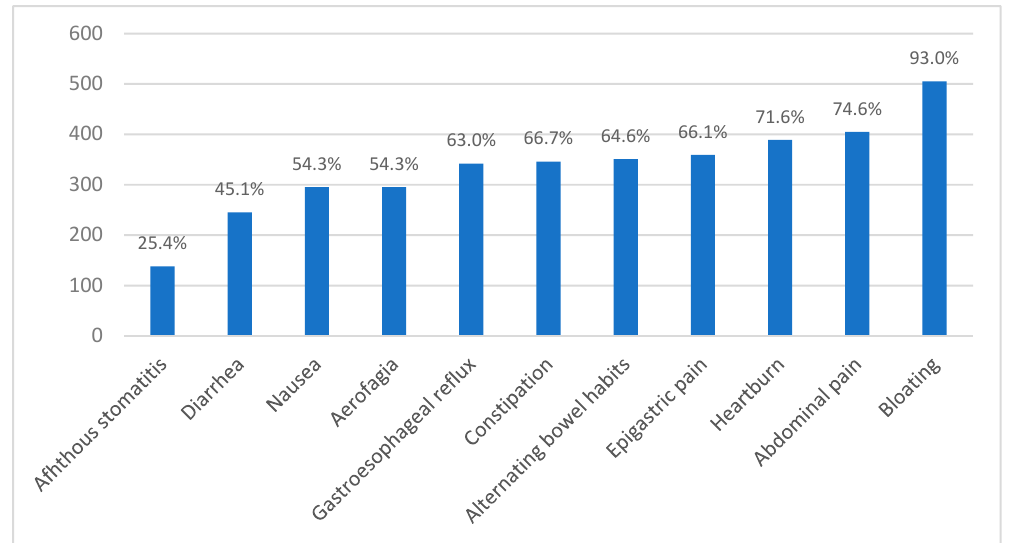
Figure 2. Gastrointestinal symptoms in Brazilian NCGS subjects (N = 543).